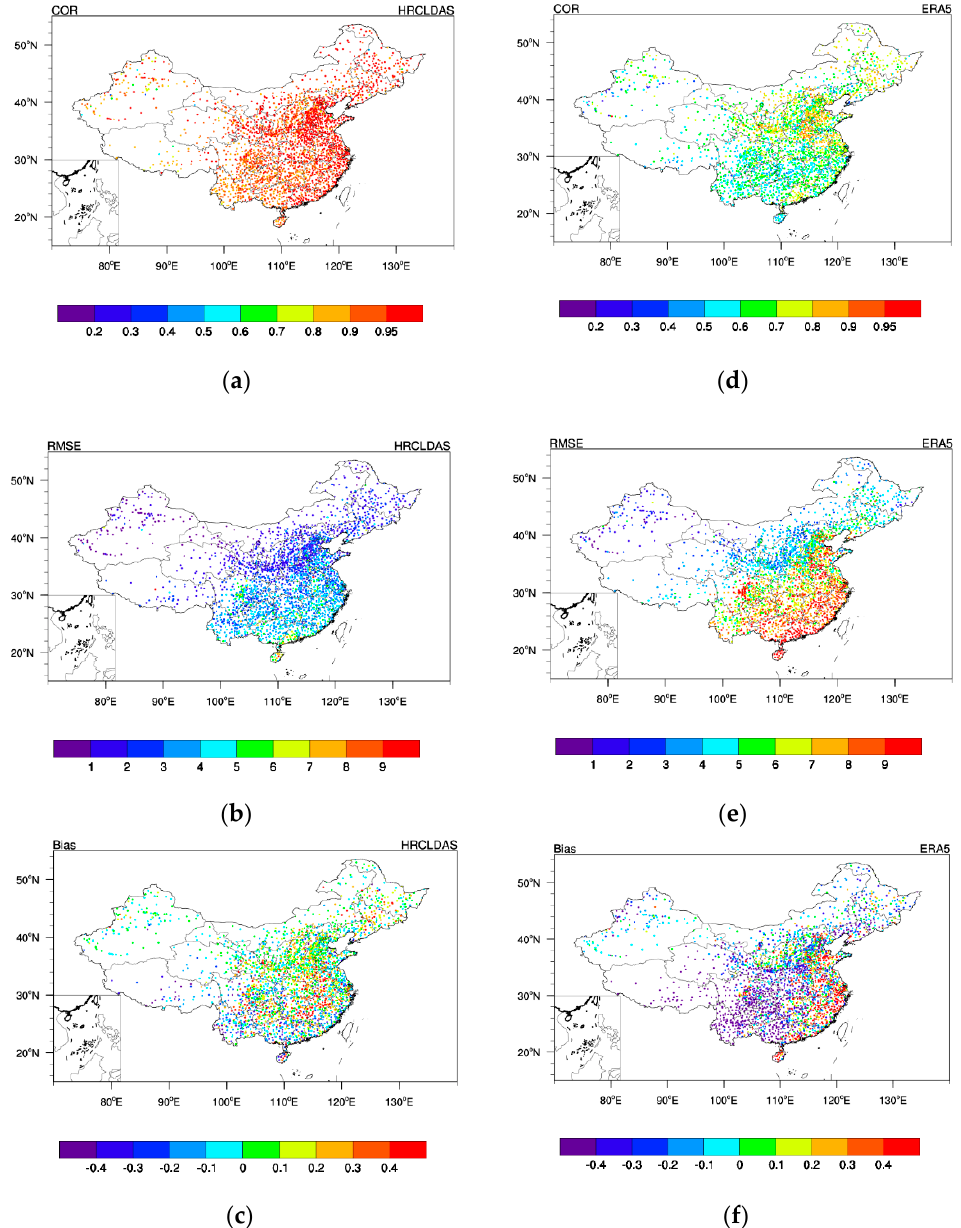
Figure 7. Spatial distribution of COR, RMSE and bias between the precipitation of HRCLDAS and ERA5 and the observed precipitation. ( a – c ) represent the spatial distribution of COR, RMSE and bias of HRCLDAS, respectively; ( d – f ) represent the spatial distribution of COR, RMSE and bias of ERA5, respectively.